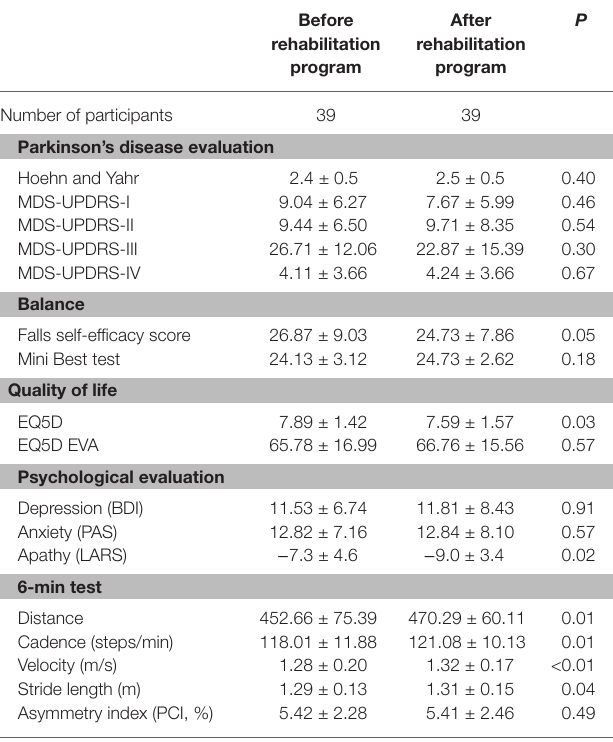
TABLE 1 | Clinical characteristics of patients with Parkinson’s disease (PD) before and after treatment.